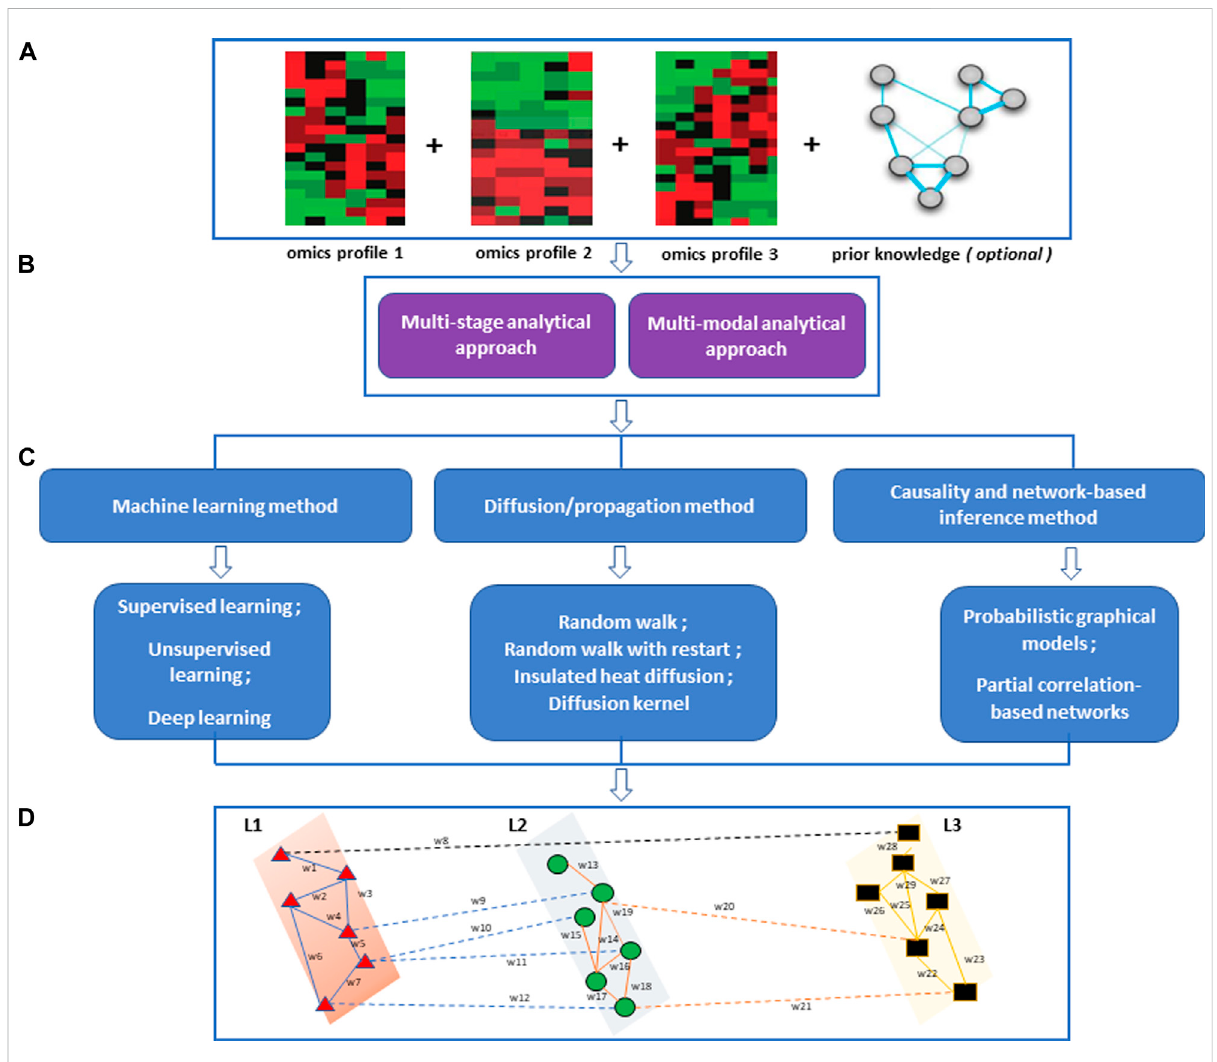
FIGURE 1 An overview of the multi-omics integration approach and the methods for network-based integration. (A) Processed omics data and prior knowledge for integrative analysis. (B) An integrative multi-omics approach that could be implemented. (C) Integrative network-based methods (D) Multi-layered network showing intra-layer interaction (solid lines) and crosstalk (dashed lines) across different layers (L1, L2, L3). The nodes are shapedandcolouredtorepresentdifferentomicsfeatureswithintheomicslayerstheyareinvolvedin.Theedgesarecolouredtoshowdifferent interactions within and between omics